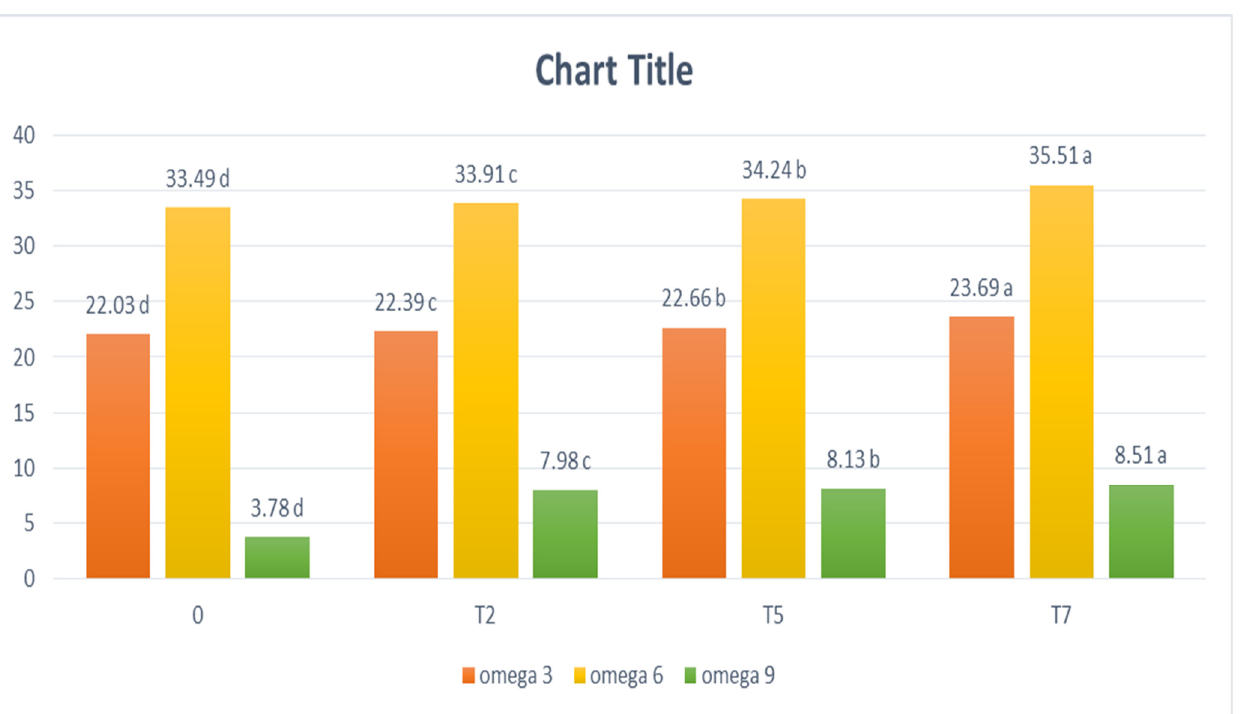
Column values with the same letters were not significantly different ( p ≤ 0.05). Means with different letters in the same column are significant at ( p ≤ 0.05). * Values are the average of two replicates ± the standard deviation. C, control: 100% wheat flour; T1–T8 are presented by 85:5, 80:10, 75:15, 70:20, 65:25, 60:30, 55:35 and 50:40 as % of resistant starch and lupin in the presence of 10% flaxseed flour for all the treatments.